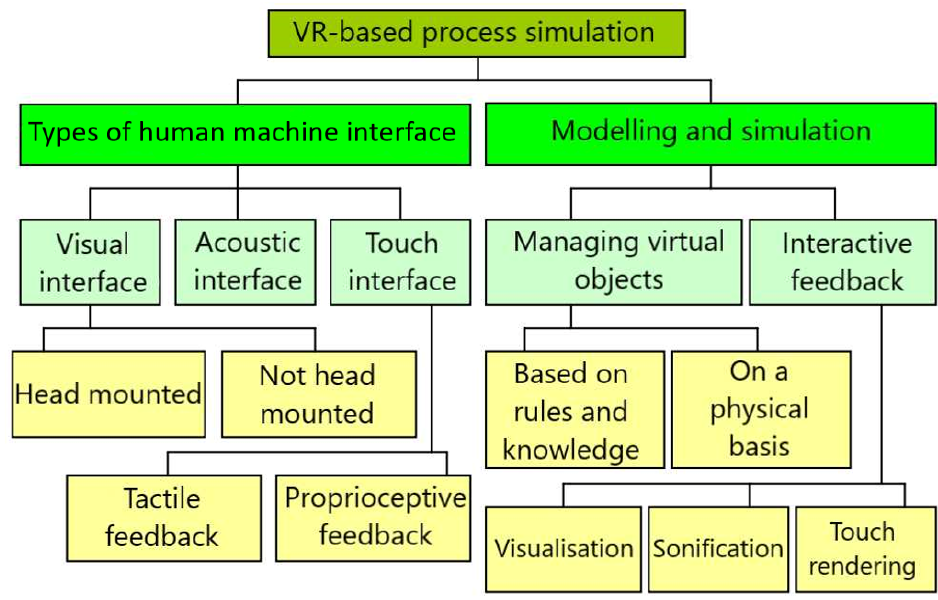
Figure 1. VR Process Simulation